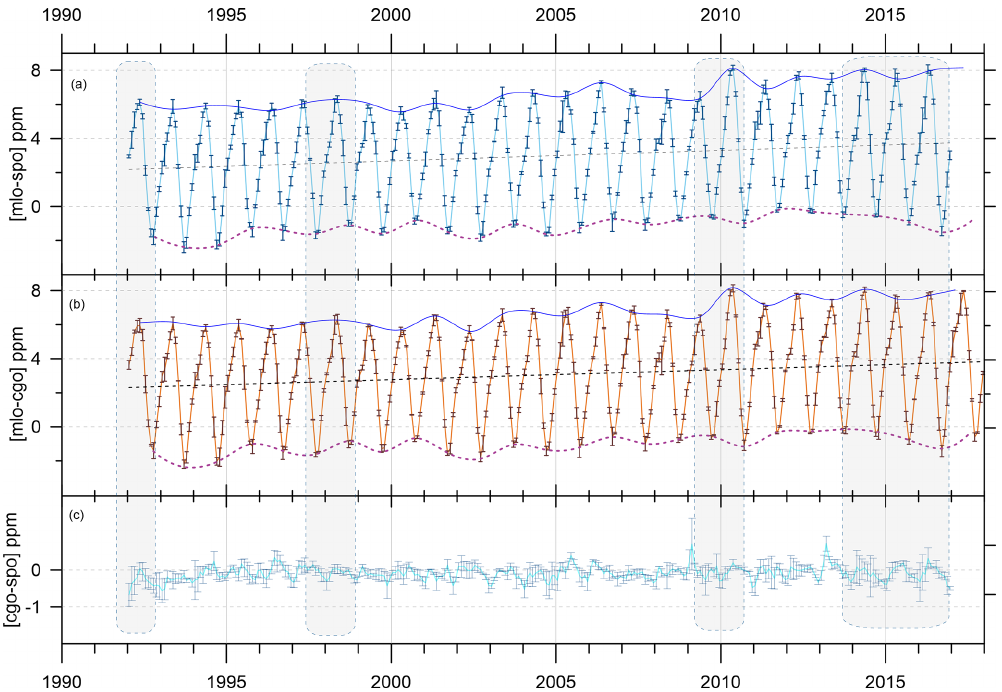
Figure 3. Composite station difference data showing the network ensemble average and standard deviation of monthly CO 2 for (a) mlo– spo, (b) mlo–cgo, and (c) cgo–spo (on a doubly expanded scale). Linear regressions through the IH records are black-dotted lines. Spline polylines visually link peaks (blue, solid) and dips (red, dotted) of the seasonal IH differences. Grey-shaded and rounded panels indicate El Niño periods with strongly anomalous equatorial zonal